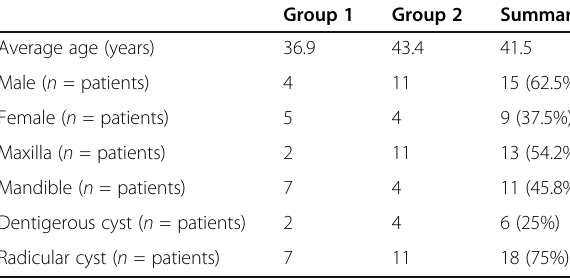
Table 2 Patient demographics according to